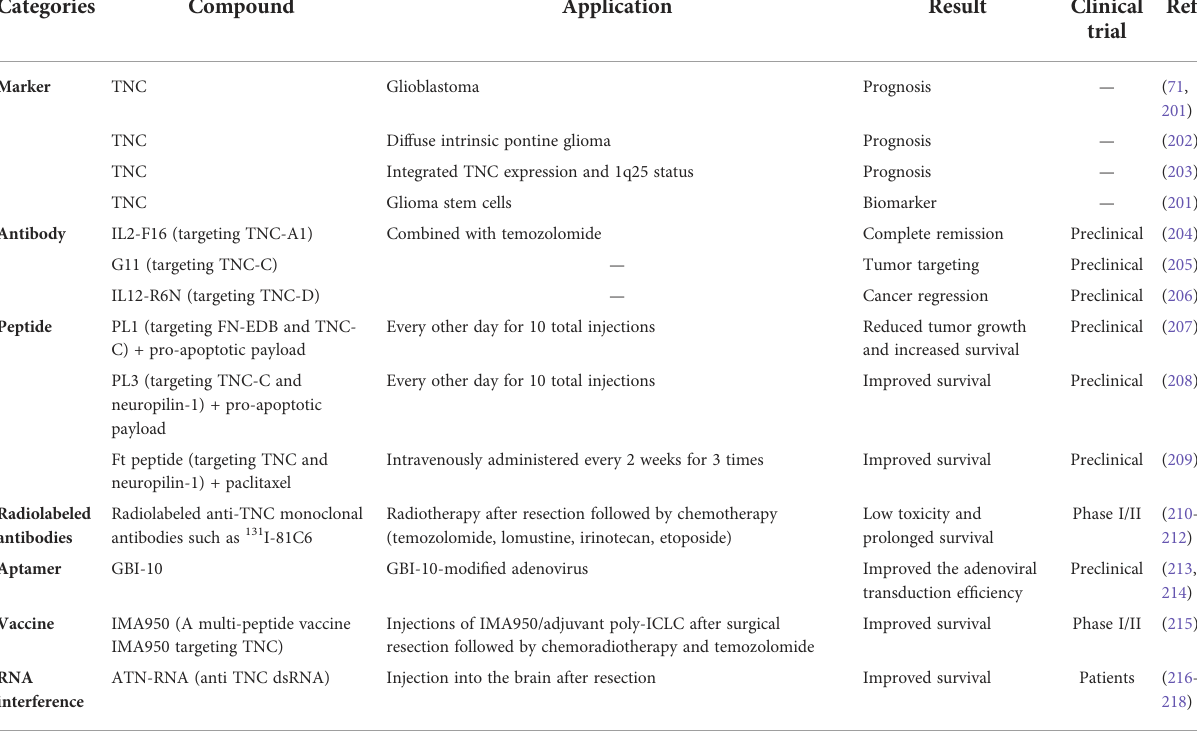
TABLE 1 The clinical applications of TNC in